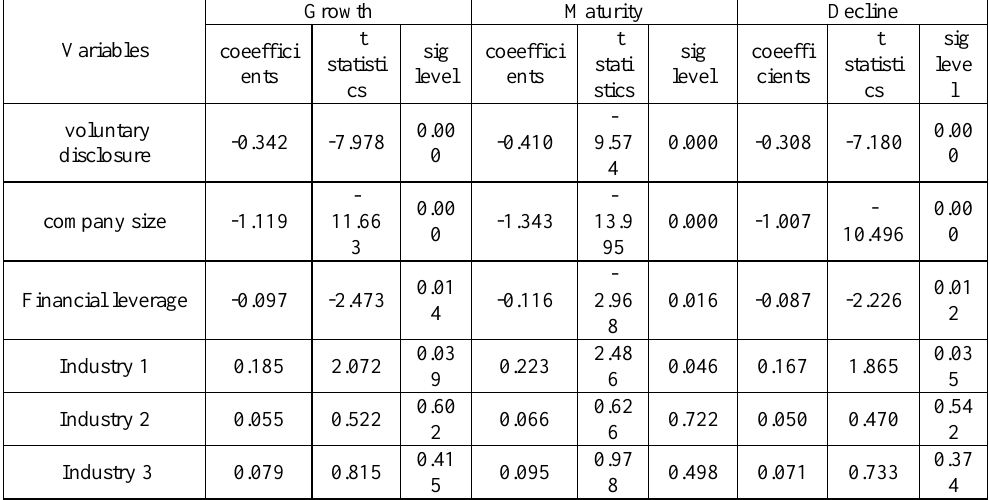
Table 7. Test results of the relationship between voluntary disclosure and